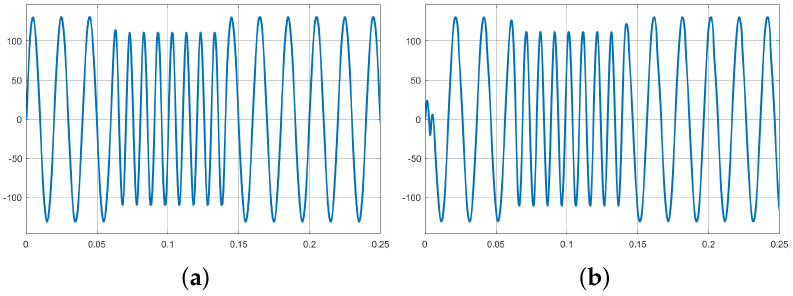
Figure 17. Load voltage waveform with f 0 = 180 Hz, ∆ = 15% and f sw = 2000 Hz, instantaneous change of operating frequency ( a ) SVM, ( b ) SVM-FSM.